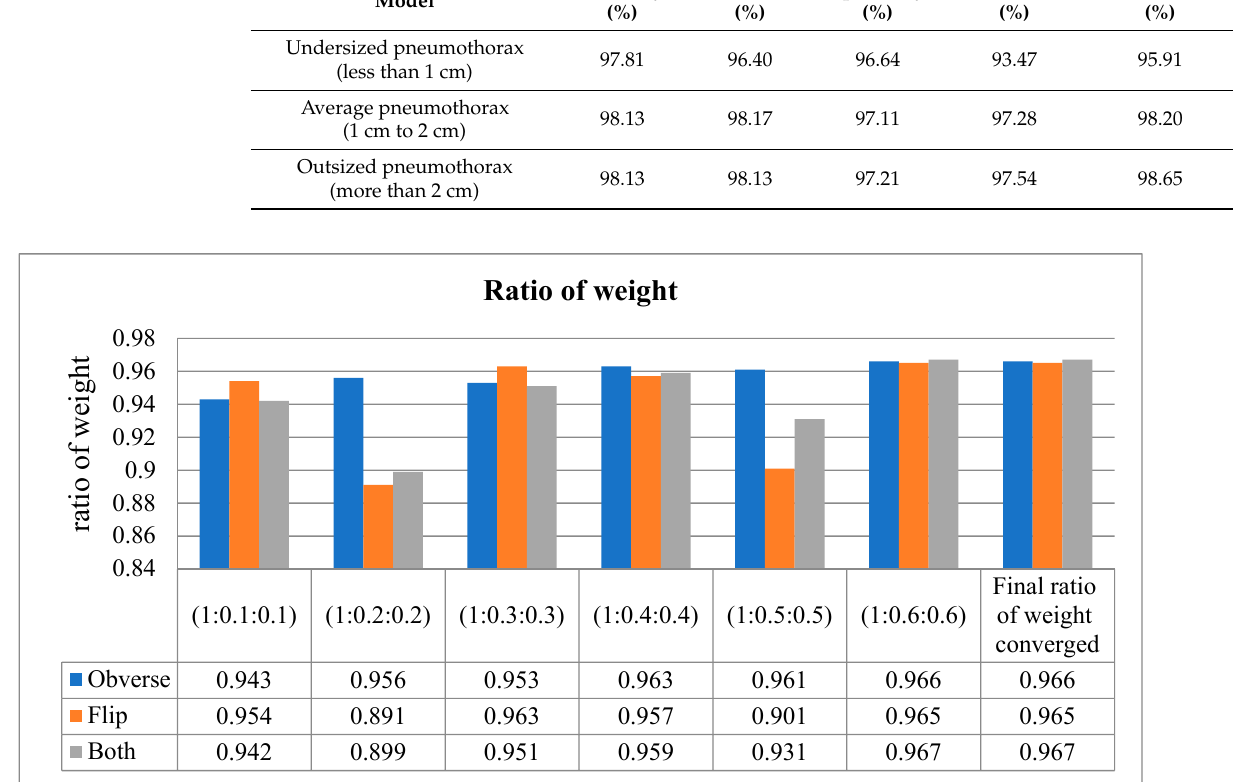
Figure 9. Ratio of weight (converged at 1:0.6:0.6).